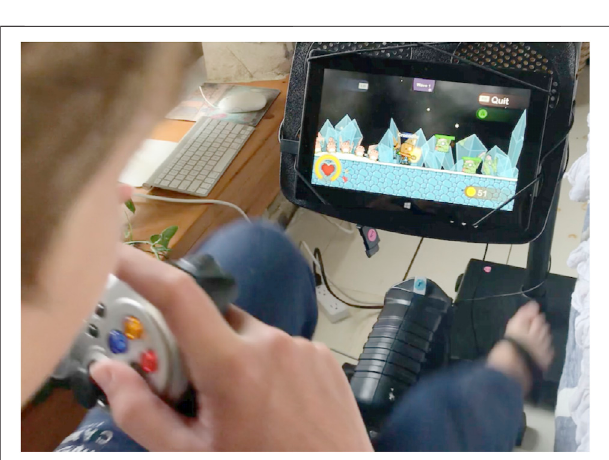
FIGURE 2 | Child playing Liberi . The child pedals to move their avatar in the game and uses a standard game controller to specify movement direction and perform